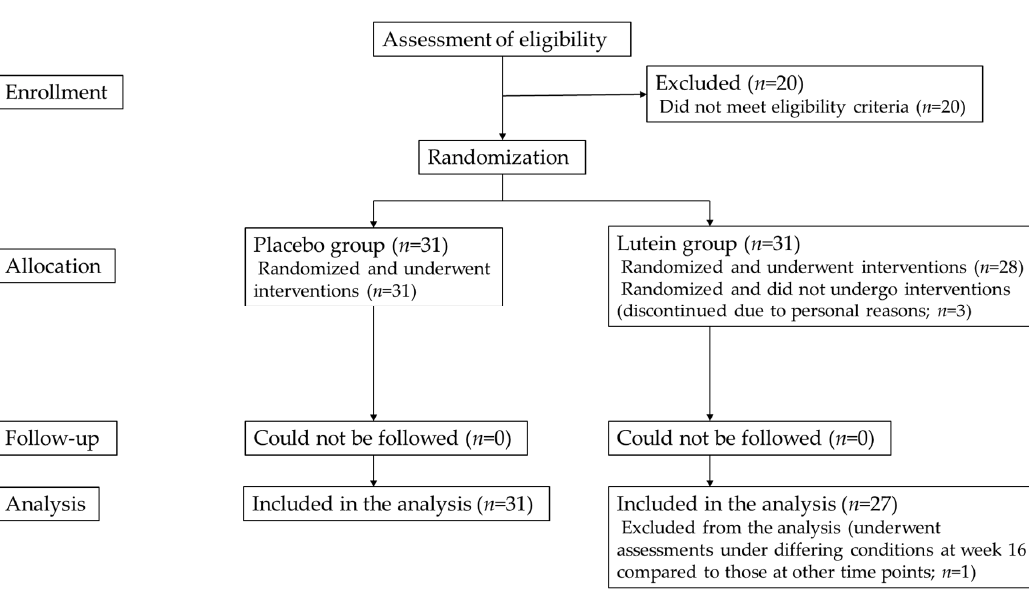
Table 4. Changes in serum lutein levels and macular pigment optical density (MPOD) values after supplementation.